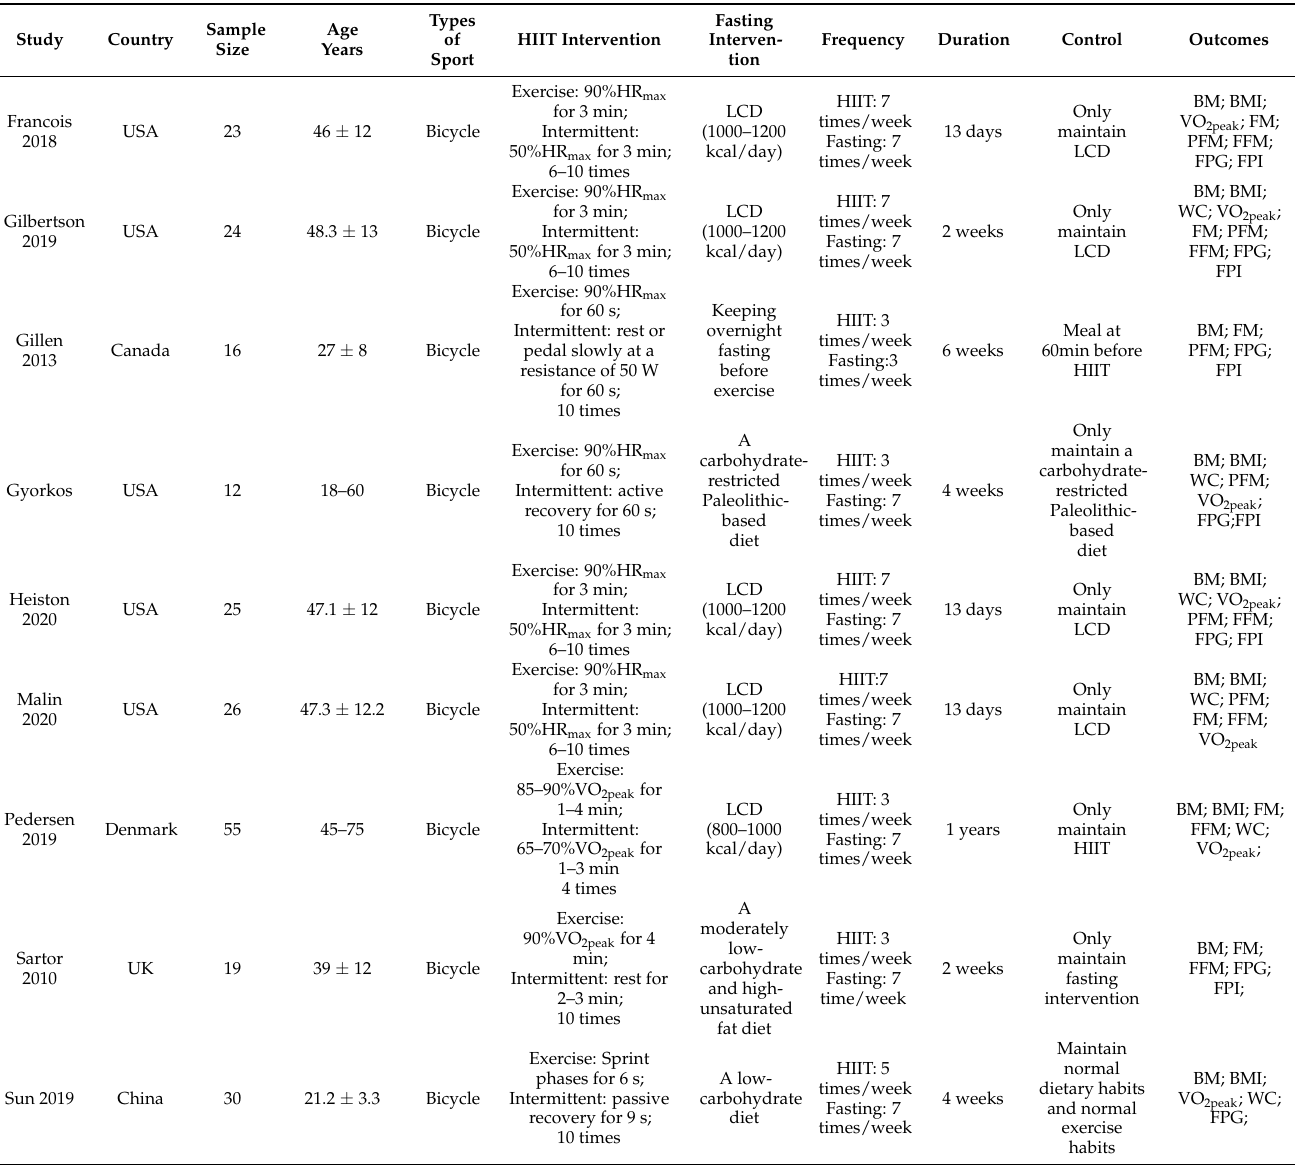
Table 3. The characteristics of included